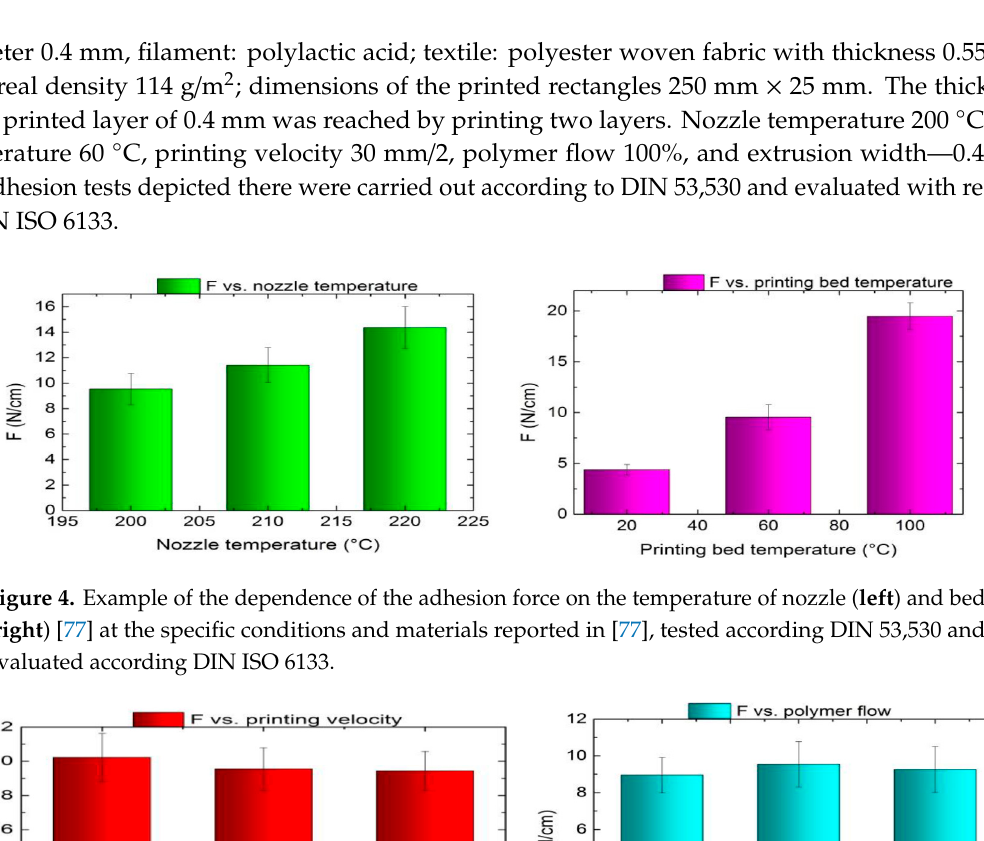
Figure 4. Example of the dependence of the adhesion force on the temperature of nozzle ( left ) and bed ( right ) [77] at the specific conditions and materials reported in [77], tested according DIN 53,530 and evaluated according DIN ISO 6133.